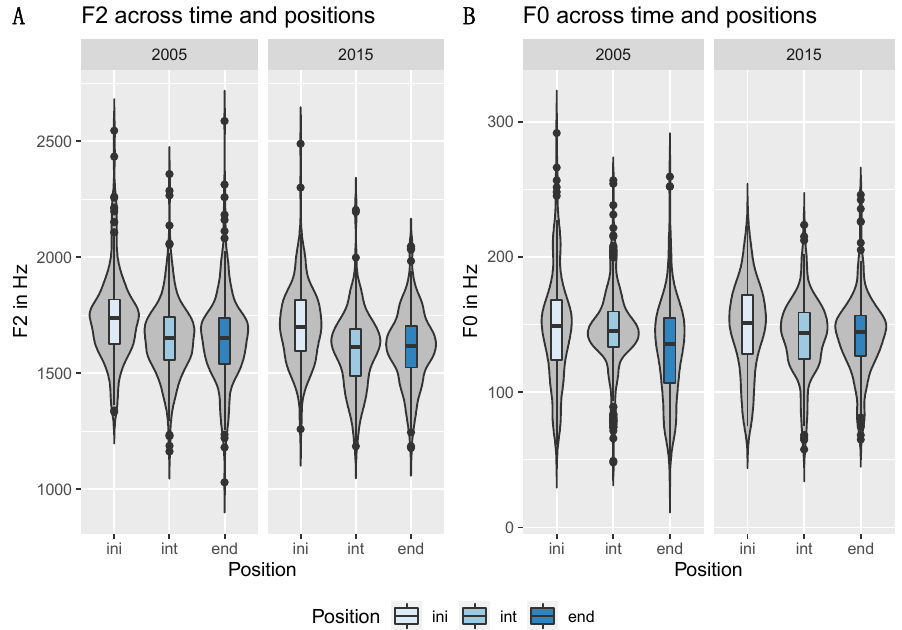
Figure 1. Violin plots showing rotated kernel density and boxplots with median values (black horizontal line) for ( A ) F2 in Hz and ( B ) f0 in Hz. Data are split by TIME of recording (2005 and 2015) and POSITION (initial, internal, end) of the filler particle.